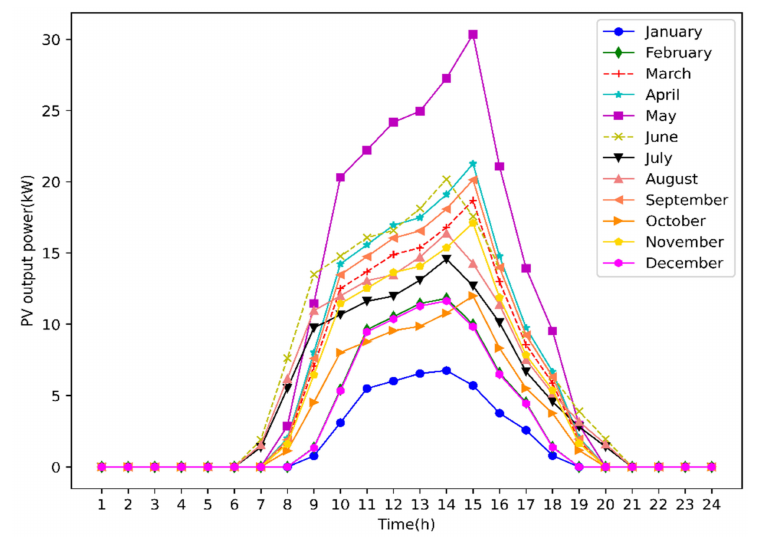
Figure 4. Typical PV output curves in the 12 months of a